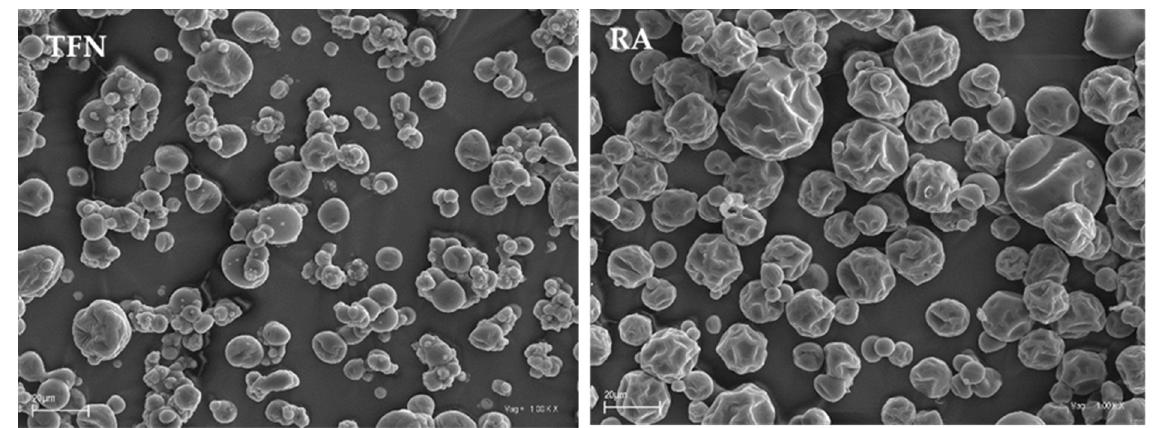
Figure 2. Microstructure of spray-dried beetroot juice particles (magnification 500×) at different process scales (ML—mini- laboratory scale, ST—semi-technical scale, SI—small industrial scale, LI—large industrial scale).